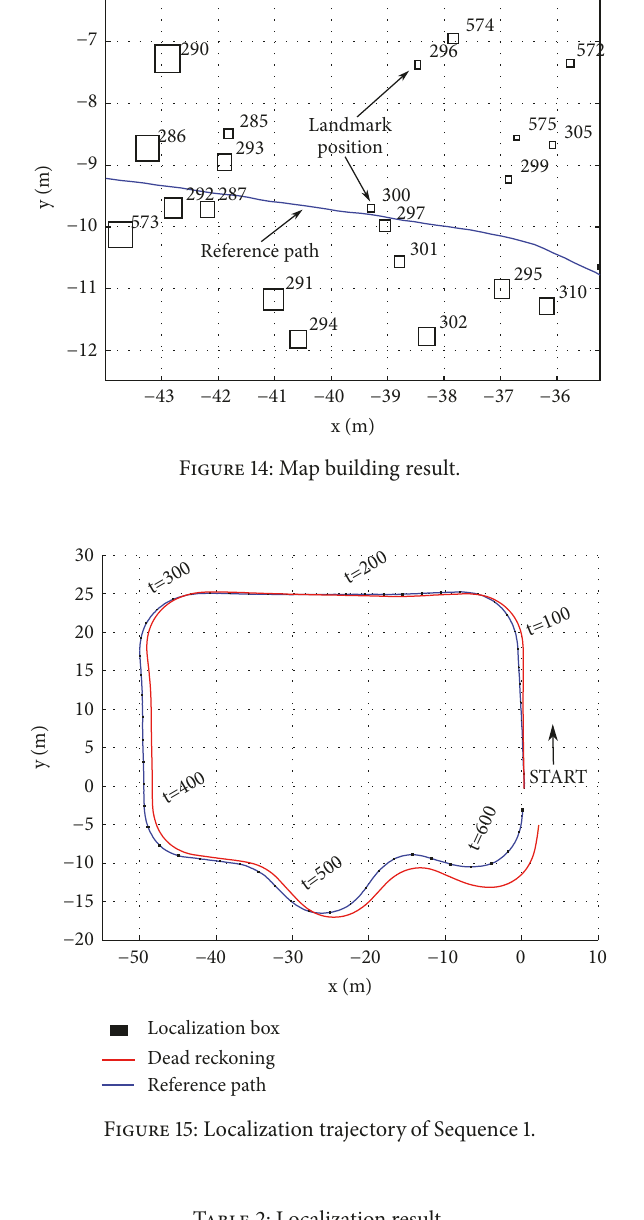
Table 2: Localization result.